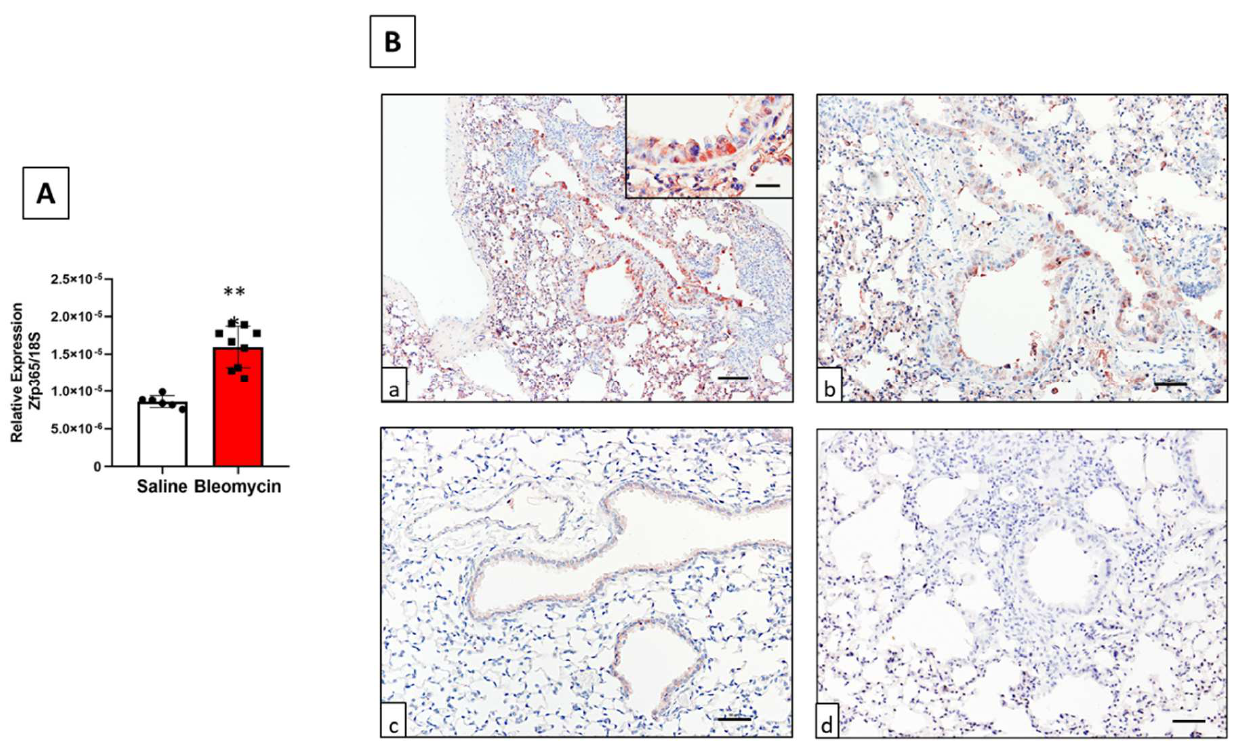
Figure 2. Zfp365 is overexpressed in lungs from mice exposed to bleomycin after 21 days. ( A ) Zfp365 expression by qPCR in lungs of mice treated with bleomycin ( n = 9) or saline solution ( n = 6). The graph represents the mean ± SD. ** p < 0.001 by a two-tailed Student’s t -test with Welch’s correction. ( B ) IHC of lung tissues from mice instilled with saline solution or bleomycin. ( a , b ) Bleomycin-treated mice showed immunoreactive protein primarily in alveolar and bronchial epithelial cells and some stromal cell populations ( n = 2) (scale bars 100 µ m, 50 µ m, and inset 25 µ m). ( c ) Immunostaining in control mice instilled with saline solution ( n = 2) (scale bar 50 µ m). ( d ) Immunostaining of bleomycin-treated mice without the primary antibody (scale bar 100 µ m).